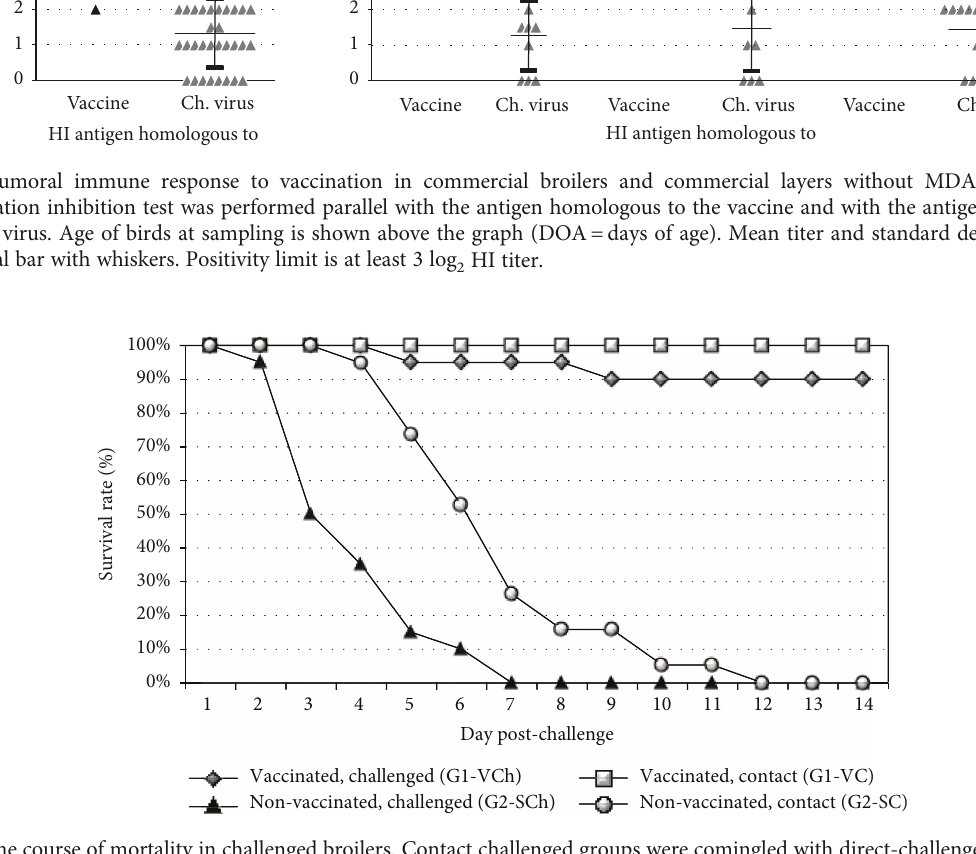
Figure 3: Time course of mortality in challenged broilers. Contact challenged groups were comingled with direct-challenged groups from 8 hours postchallenge. Recording date refers to the time after direct